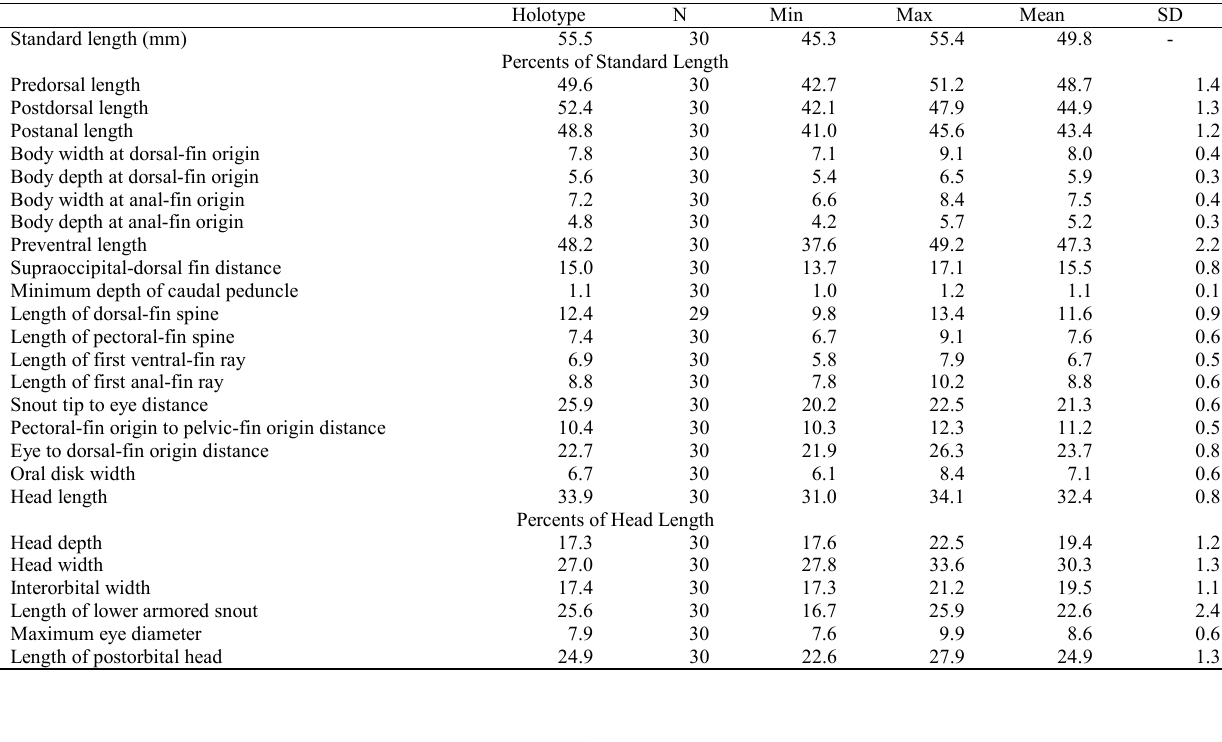
Table 1 . Descriptive morphometrics of holotype and paratypes of Acestridium triplax . Values are given as percents of standard length or head length. SD = standard deviation.